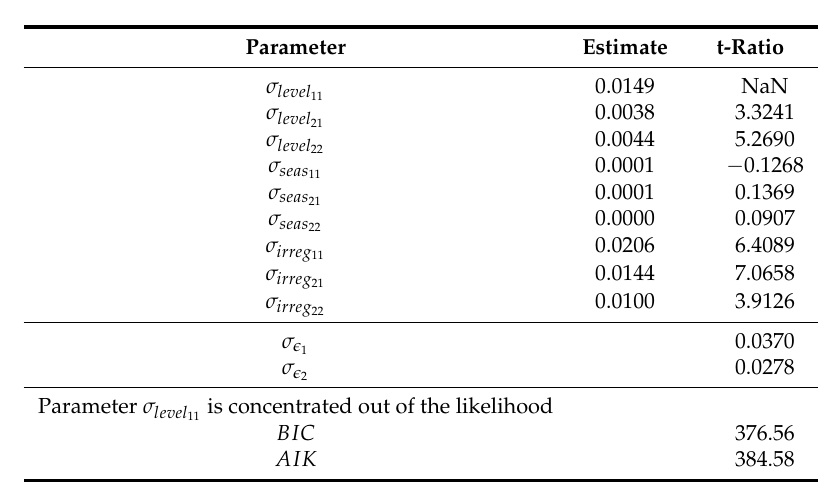
Table A16. Endogenous variables: log production of electricity log cumulated daily consumption of electricity.